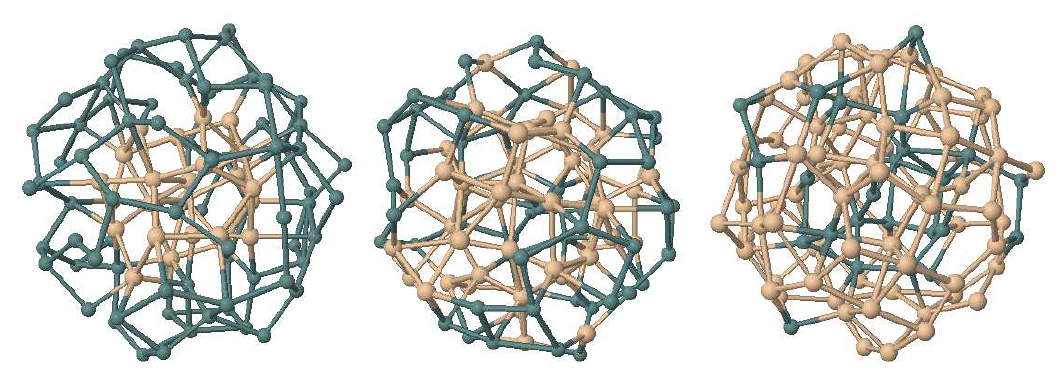
Figure 6. Optimized structures of Si-core initial geometry Si geometry Si Ge (middle) and Ge-core initial geometry Si 50 50